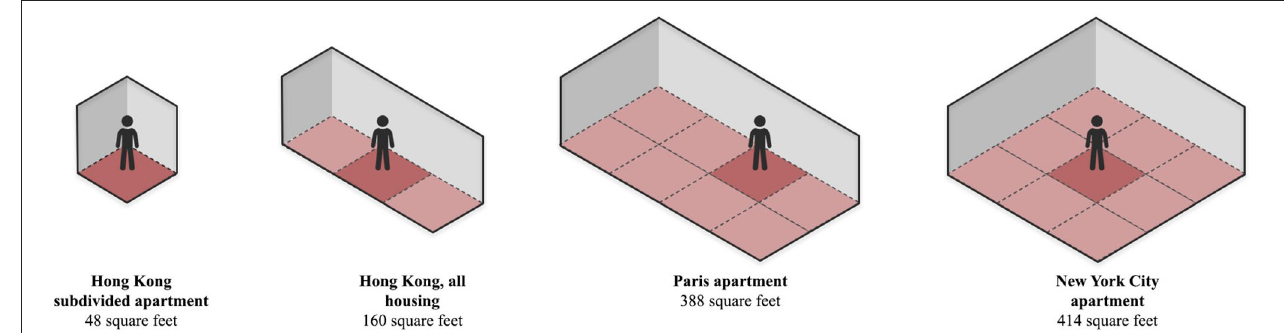
FIGURE 1 | Average living space per person around different